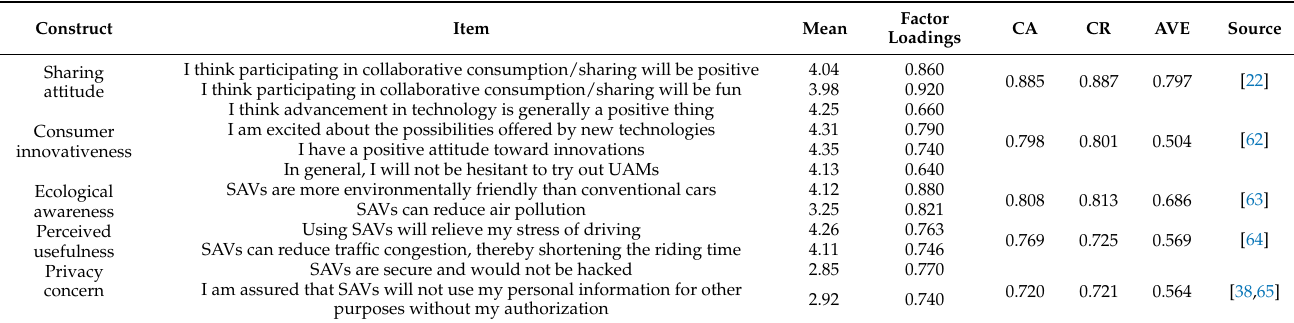
Table 5. Evaluation of the reliability and validity of the CFA model.